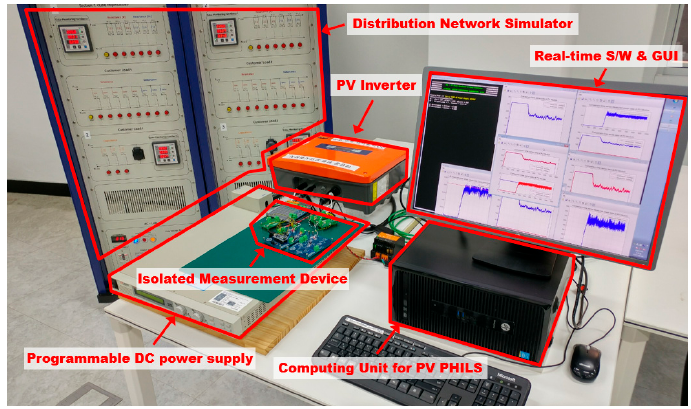
Figure 12. Experiment using the PV PHIL Simulator with a Grid-tied PV Inverter.